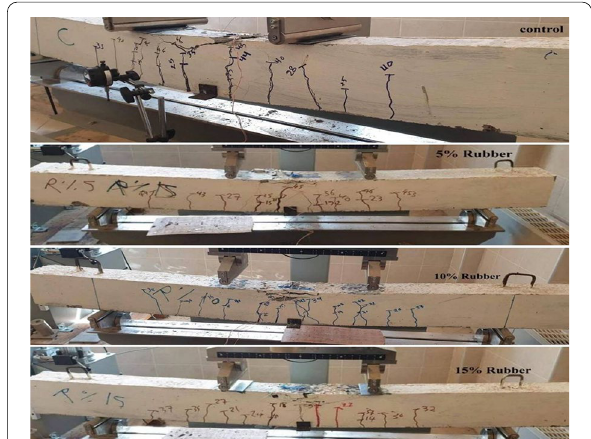
Fig. 18 Failure mode of beams containing crushed